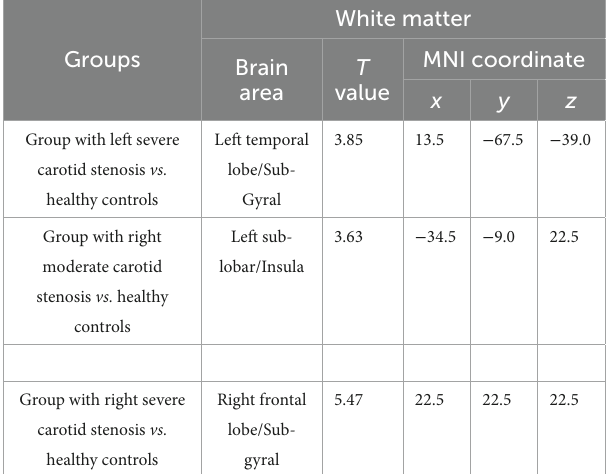
TABLE 9 Voxel-based morphometry analysis of the declined white matter volume in patients with carotid artery stenosis compared with healthy